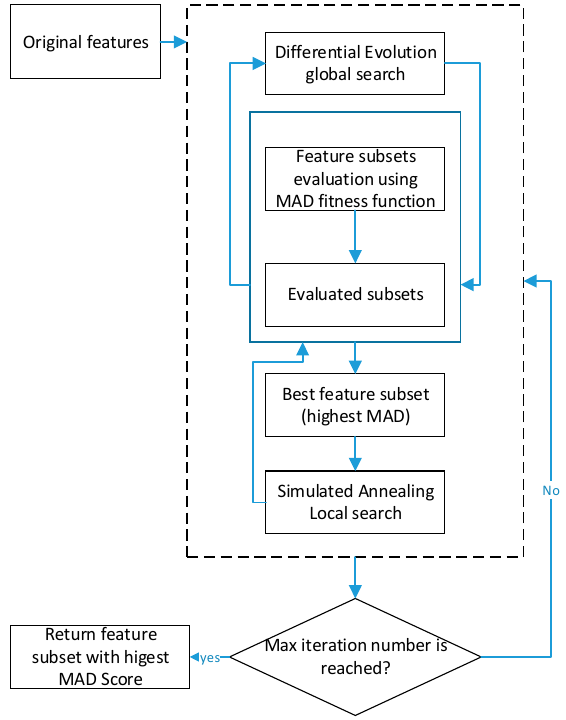
Figure 3. DDESA unsupervised feature selection.